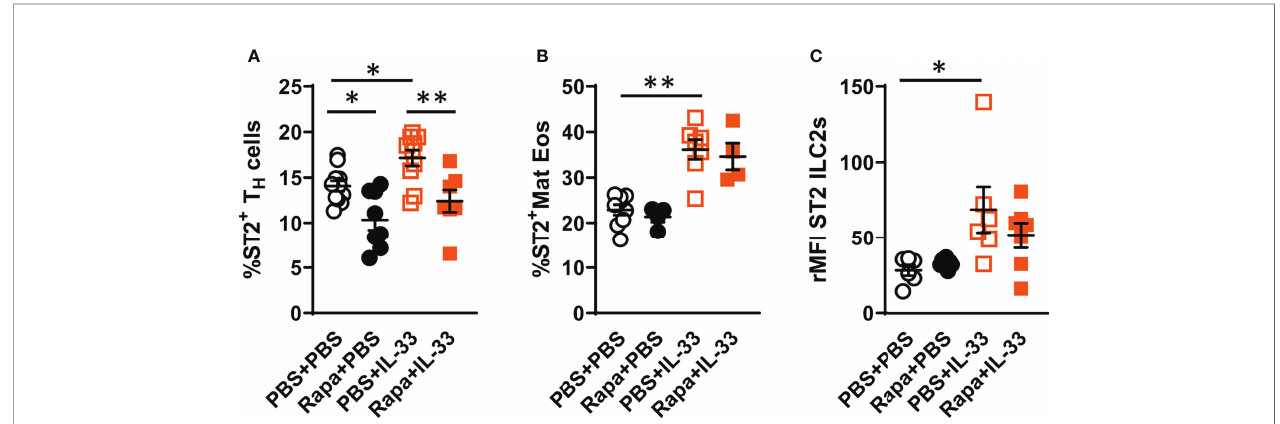
FIGURE 5 | Decreased ST2 expression on bone marrow T H cells after rapamycin treatment and IL-33 challenge. (A) Number of ST2 + T H cells and (B) mature eosinophils. (C) ST2 expression on ILC2s shown as relative mean fl uorescence intensity (rMFI). Data are representative of 1 – 3 independent experiments (4 – 11/ group). Mann-Whitney U test. *P < 0.05 and **P < 0.01. T H , T helper cell; ST2=IL-33 receptor; Mat Eos, Mature eosinophil; Rapa, Rapamycin; i.p, intraperitoneal; i.n., intranasal; PBS+PBS, PBS i.p. and PBS i.n; Rapa+PBS, Rapa i.p. and PBS i.n.; PBS+IL-33, PBS i.p. and IL-33 i.n.; Rapa+IL-33, Rapa i.p. and IL-33